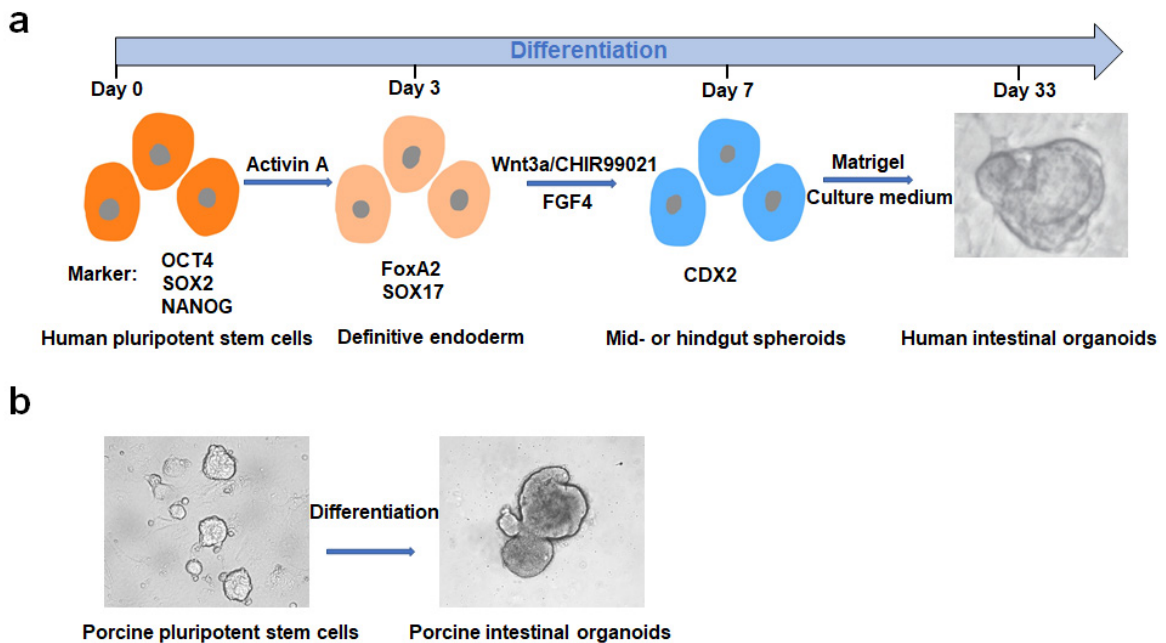
Figure 2. Schematic diagram of a specific method for inducing pluripotent stem cells to form intestinal organoids. ( a ) Pluripotent stem cells expressing pluripotency markers (OCT4, SOX2, and NANOG) are first treated with activin A to form the FoxA2 + and SOX17 + definitive endoderm. This definitive endoderm is treated with Wnt3a/CHIR99021 and FGF4 to form CDX2 + spheroids. The spheroids are embedded in Matrigel and form intestinal organoids with the addition of various growth factors. ( b ) Porcine pluripotent stem cells are cultured in the feeder-free state by adding feeder cell supernatants followed by treatment with activin A, Wnt3a, and FGF4 to form CDX2 + spheroids. The formed CDX2 + spheroids are then embedded in Matrigel and form intestinal organoids with the addition of various growth factors.